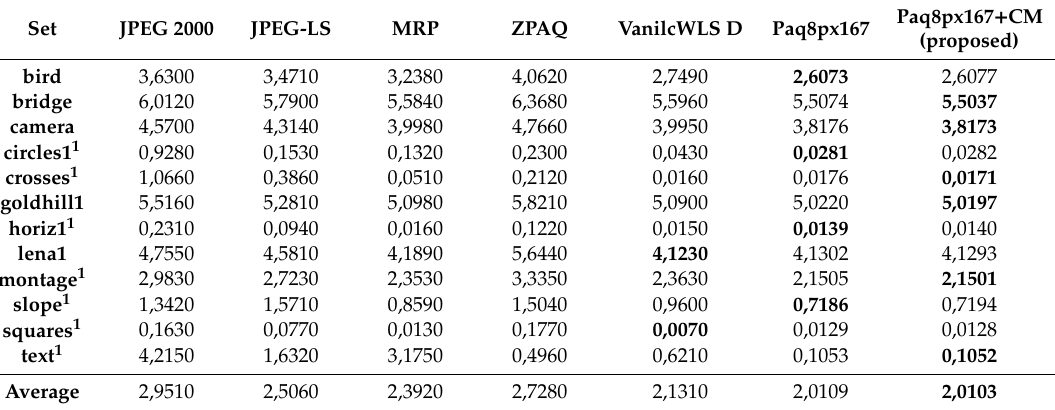
Table 1. Waterloo gray test set 1.